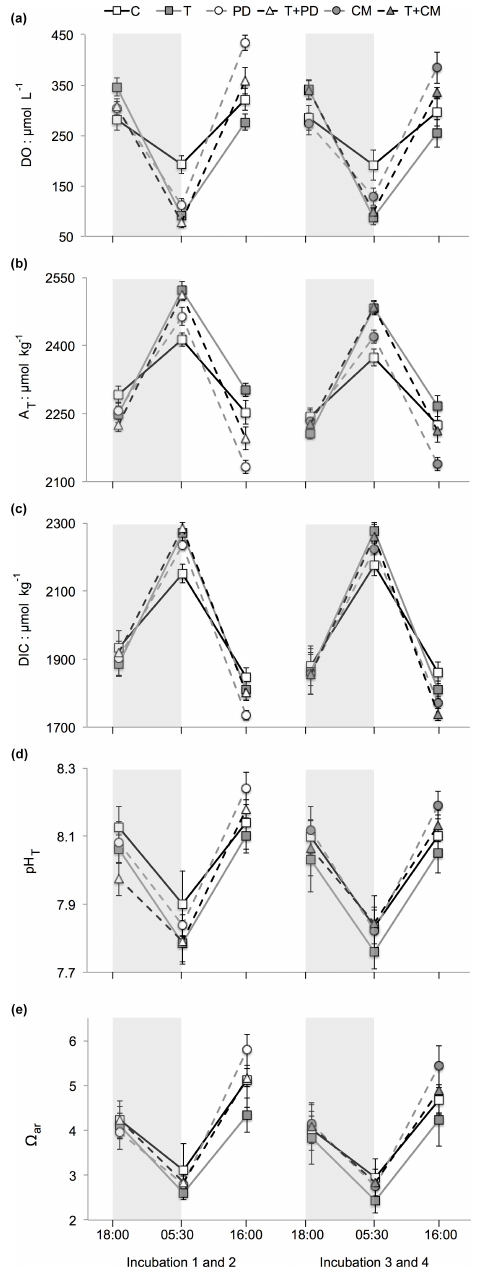
Figure 3. Water chemistry (mean ± SD) measured and calculated during the four incubations. Control ( C ), warming ( T ), phytodetri- tus (PD), coral mucus (CM), and combination ( T + PD, T + CM) treatments are averaged over the two incubations (and replicate chambers therein) in which each respective OM treatment was used ( n = 4). Shaded grey bars represent the dark, and time of sam- pling is labelled on the x axis. (a) Measured fluxes in dissolved oxygen (DO:µmol L − 1 ) . (b) Measured fluxes in total alkalinity ( A T :µmolkg − 1 ) . (c) Measured fluxes in dissolved inorganic car- bon (DIC:µmolkg − 1 ) . (d) Calculated changes in pH (total scale: pH T ) . (e) Calculated fluxes in aragonite saturation state ( (cid:127) ar ) .